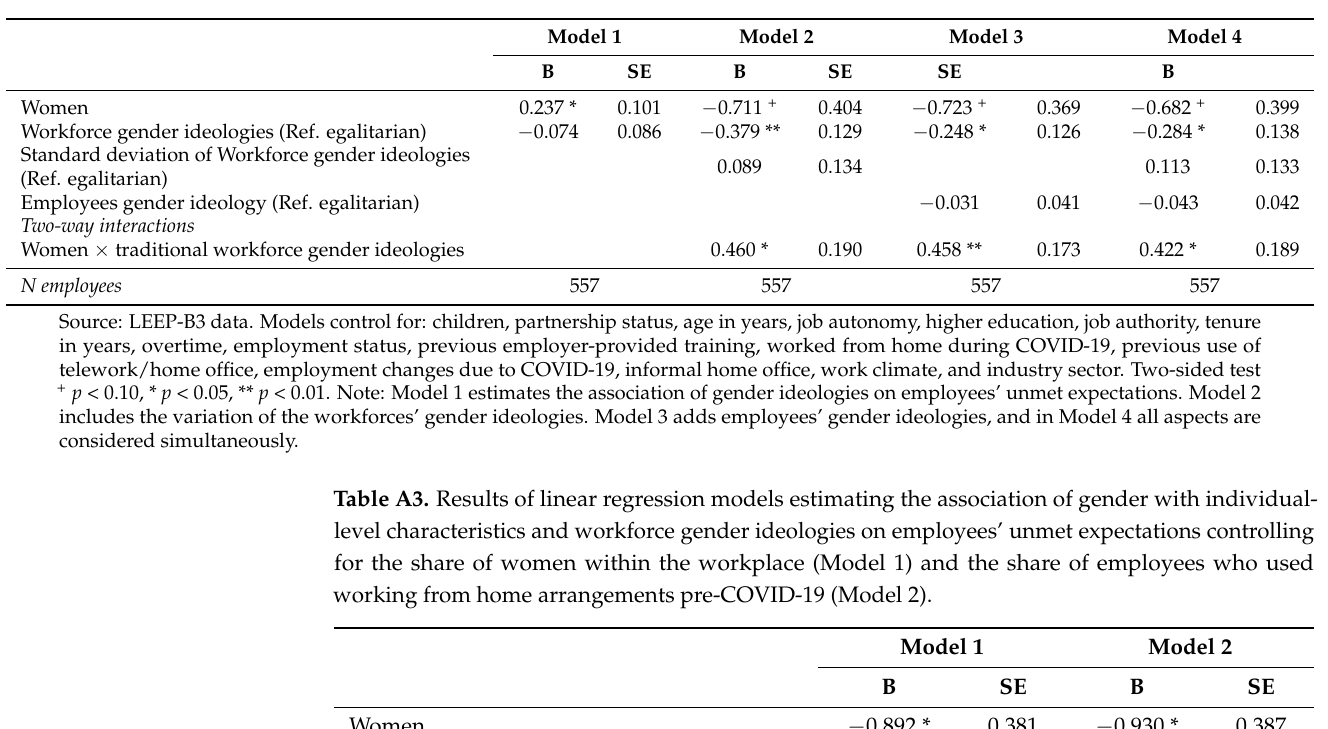
Table A2. Results of linear regression models estimating the association of gender with individual-level characteristics and workforce gender ideologies on employees’ unmet expectations.